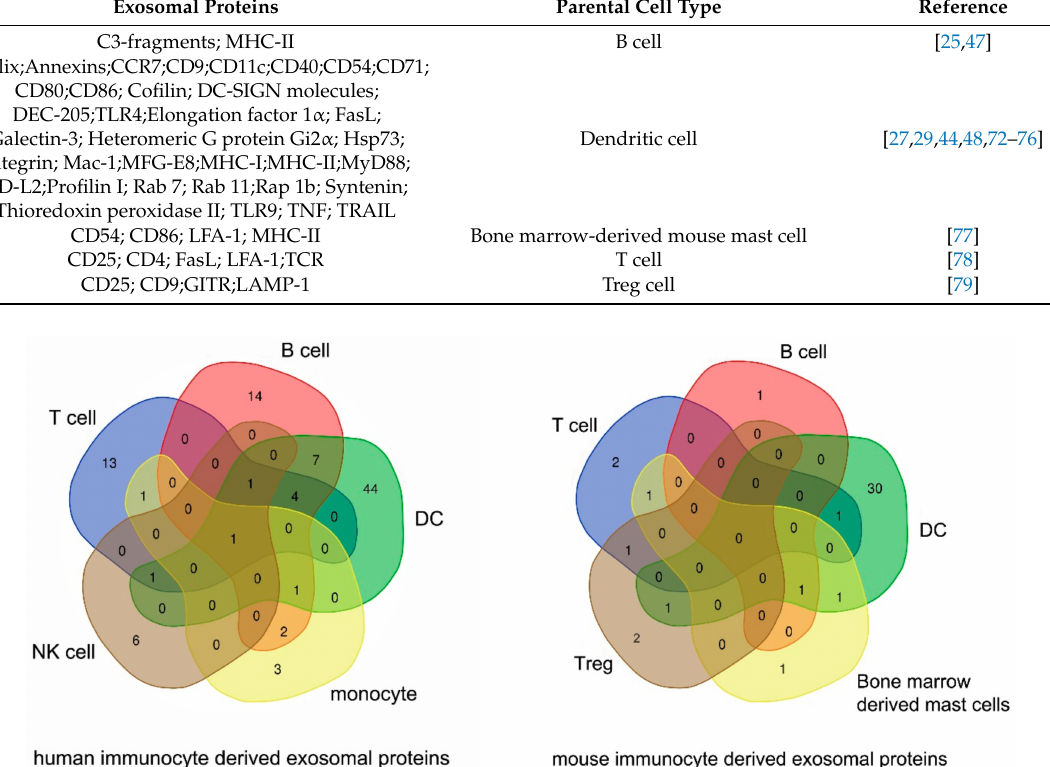
Figure 1. Venn diagram showing the distribution of proteins with immunologic function in immunocyte-derived exosomes from human and murine leukocyte populations. Distribution of proteins common to di ff erent immunocyte lineages is shown. Descriptions of the molecules are shown in Table